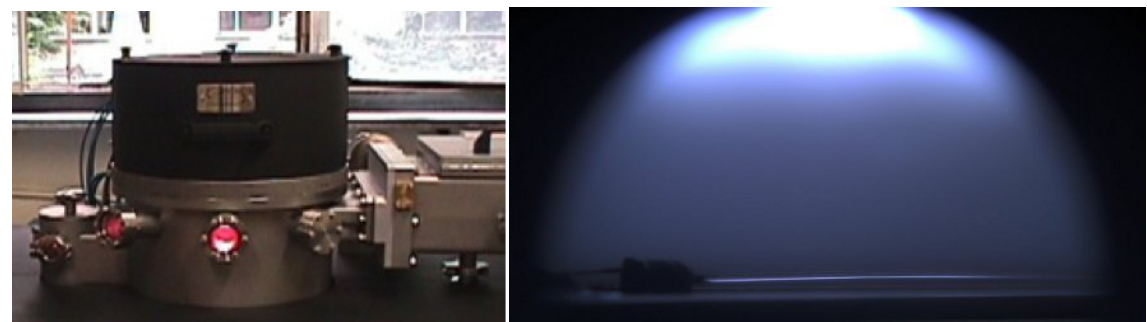
Figure 8. ( Left ) A picture of the PECVD reactor used for the deposition of the SiO film; ( Right ) An image of the plasma discharge and of the fiber during the